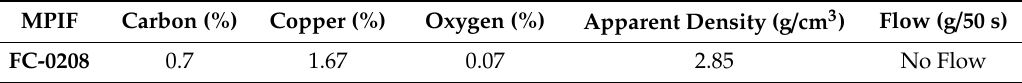
Table 2. Chemical composition (wt.%) and flow properties of the di ff usion-bonded / di ff usion-alloyed FC-0208